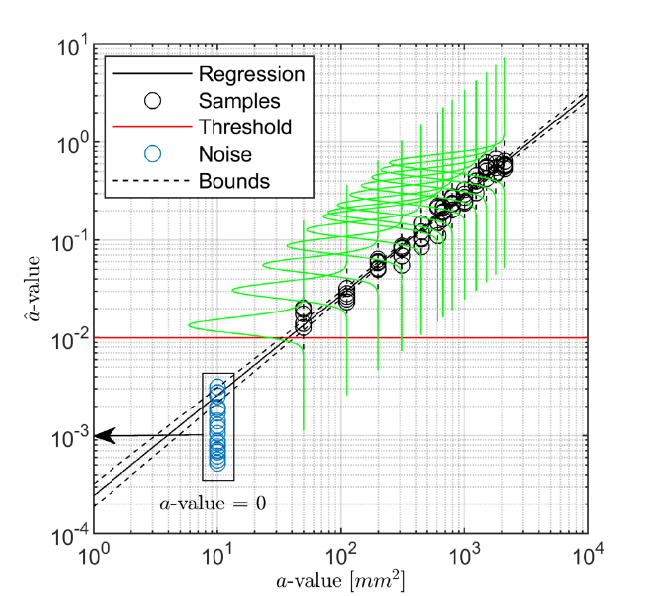
Figure 9. Noise and signal response samples along the path T3–T9 and damage D1. The regression and the signal response distribution are established using log − log model. The a -value corresponding to noise samples is zero (no-damage) and is moved along x -axis for a better visualization.